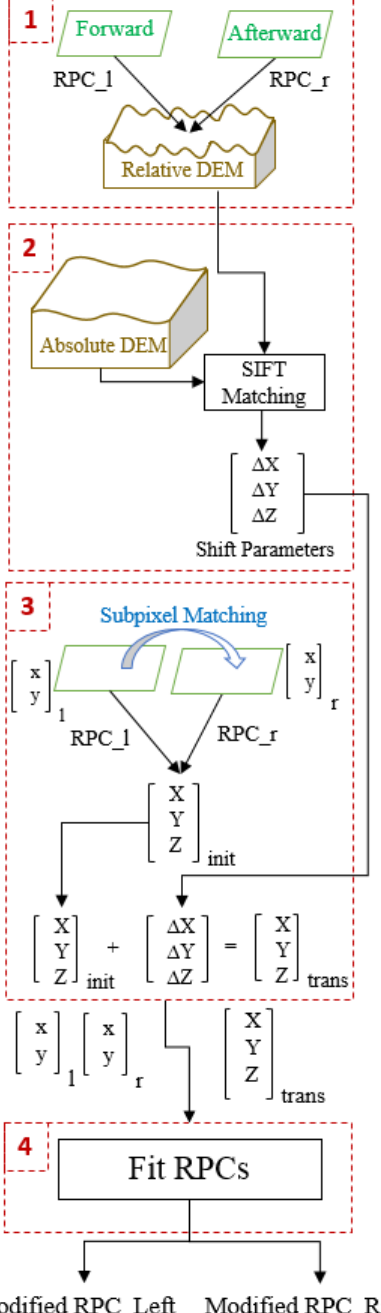
Figure 1. The main steps of proposed method for RPCs